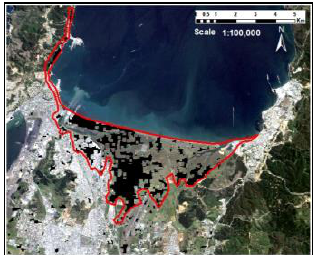
Figure 16. Overlay image of the ALOS/PALSAR extraction